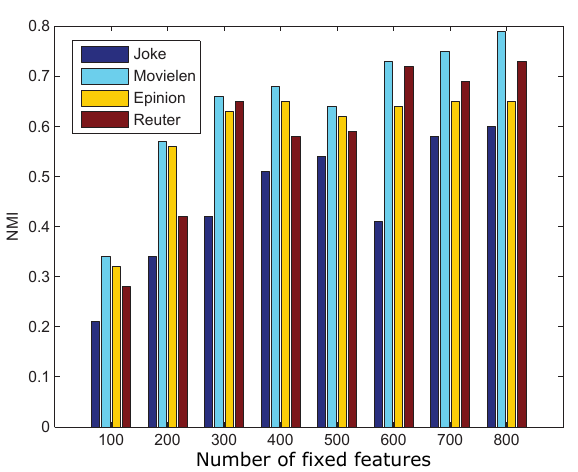
Fig. 5 NMI evaluation on different datasets.